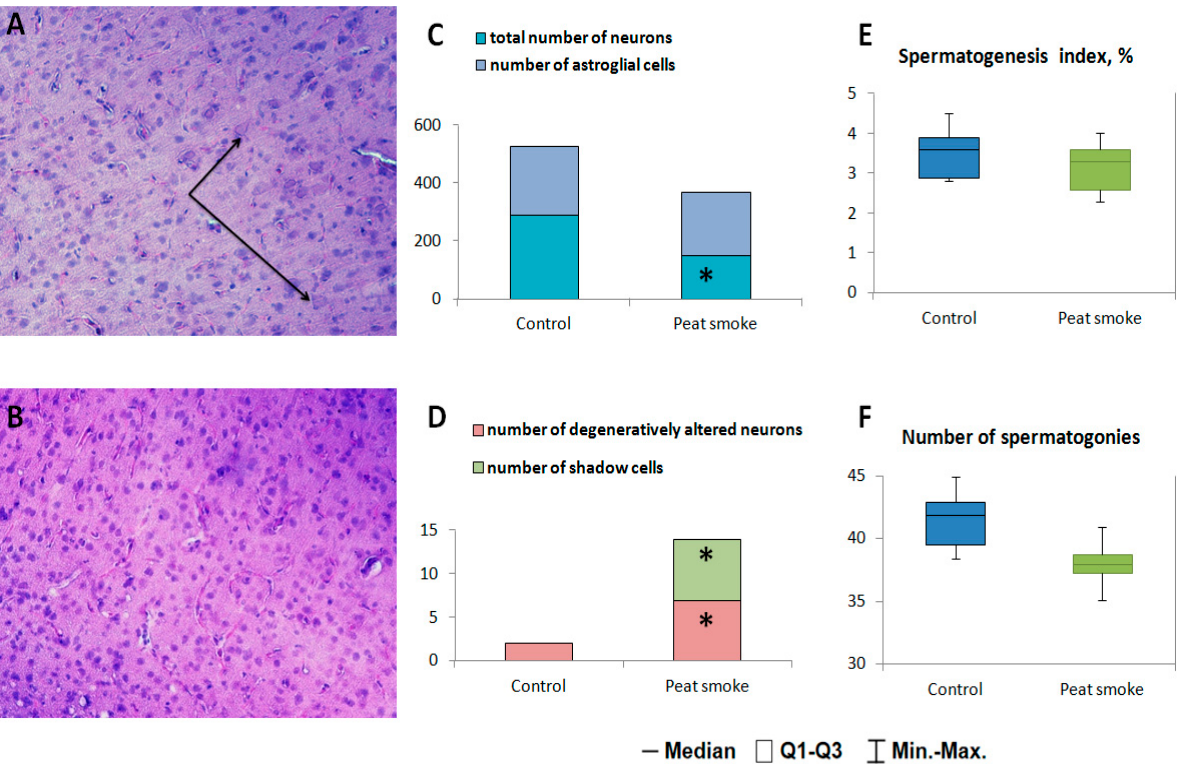
Figure 3. Results of histological investigation of the brain and testes of male F0 rats. Microphoto of brain tissue of control rats ( A ) and peat smoke ( B ): ↑ —shadow cells. Hematoxylin–eosin stain. Mag. X100; ( C ) Number of normal neurons and astroglial cells; ( D ) Number of degeneratively altered neurons and shadow cells; ( E ) Index of spermatogenesis; ( F ) Number of spermatogonia. Data are presented as median and IQR. * p < 0.05.